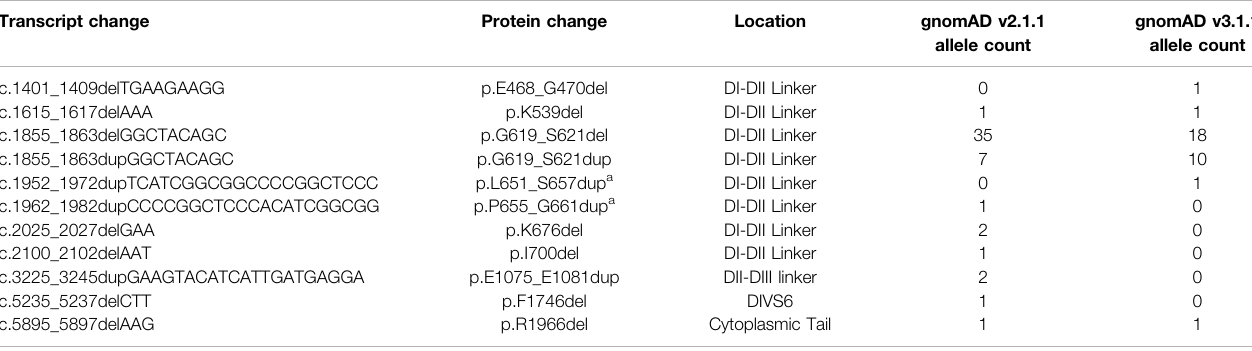
TABLE 2 | In-frame SCN8A variants observed in the gnomAD